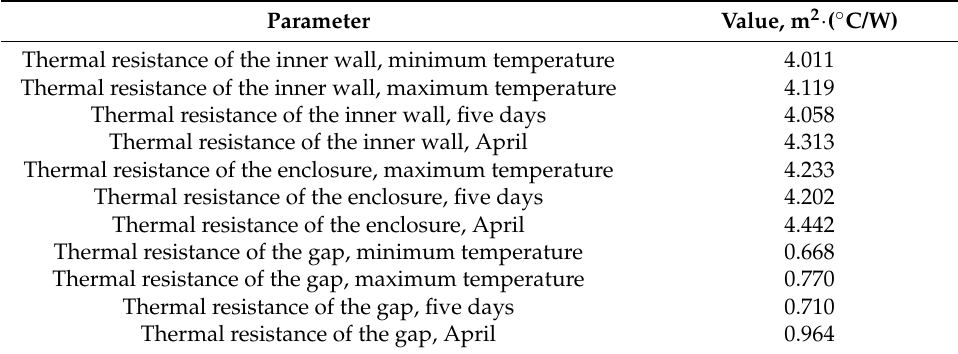
Table 7. Thermal resistance of the enclosure according to Figure